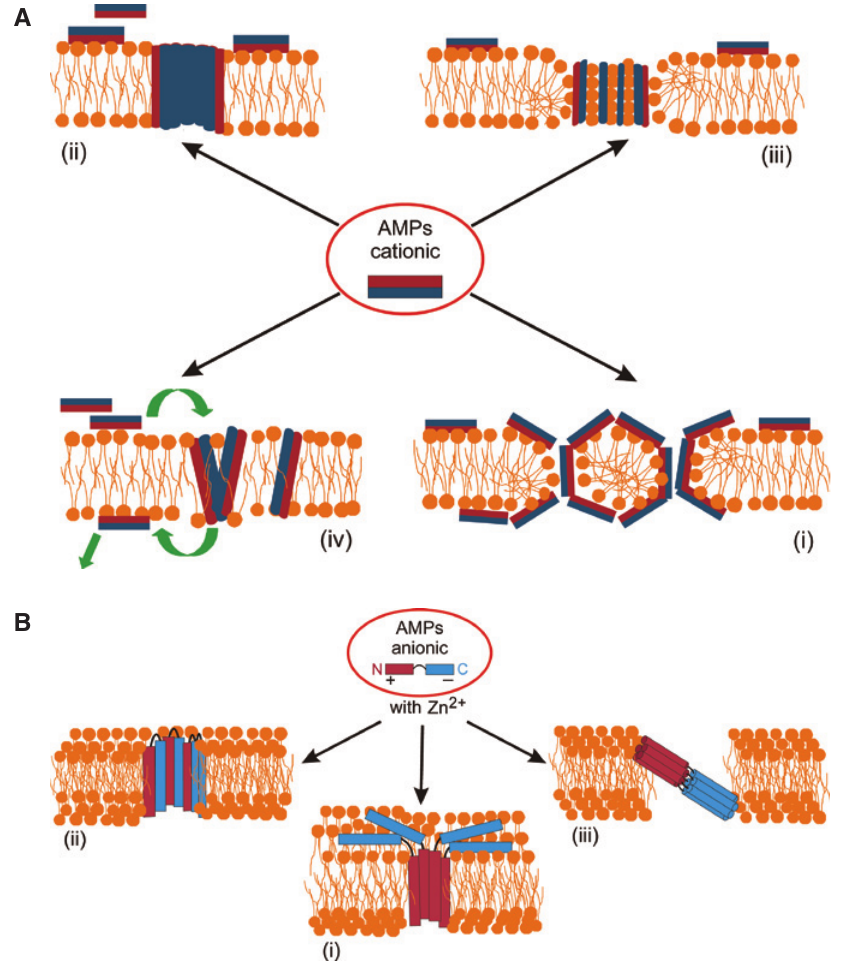
Figure 1: Interactions of cationic (A) and anionic (B) defense peptides with bacterial cell membrane. (A) Four basic models of cationic AMPs interaction with a PL bilayer (orange) are presented. The cationic and hydrophobic domains are demonstrated in blue and red, respectively. The green arrows indicate possibility of traversing of a defense peptide through a microbial membrane into a cell. (B) Three proposed models of interaction of dermcidin-derived peptides as examples of anionic AMPs with a lipid membrane (orange) are shown. The cationic and anionic domains are colored red and blue, respectively. See text for further